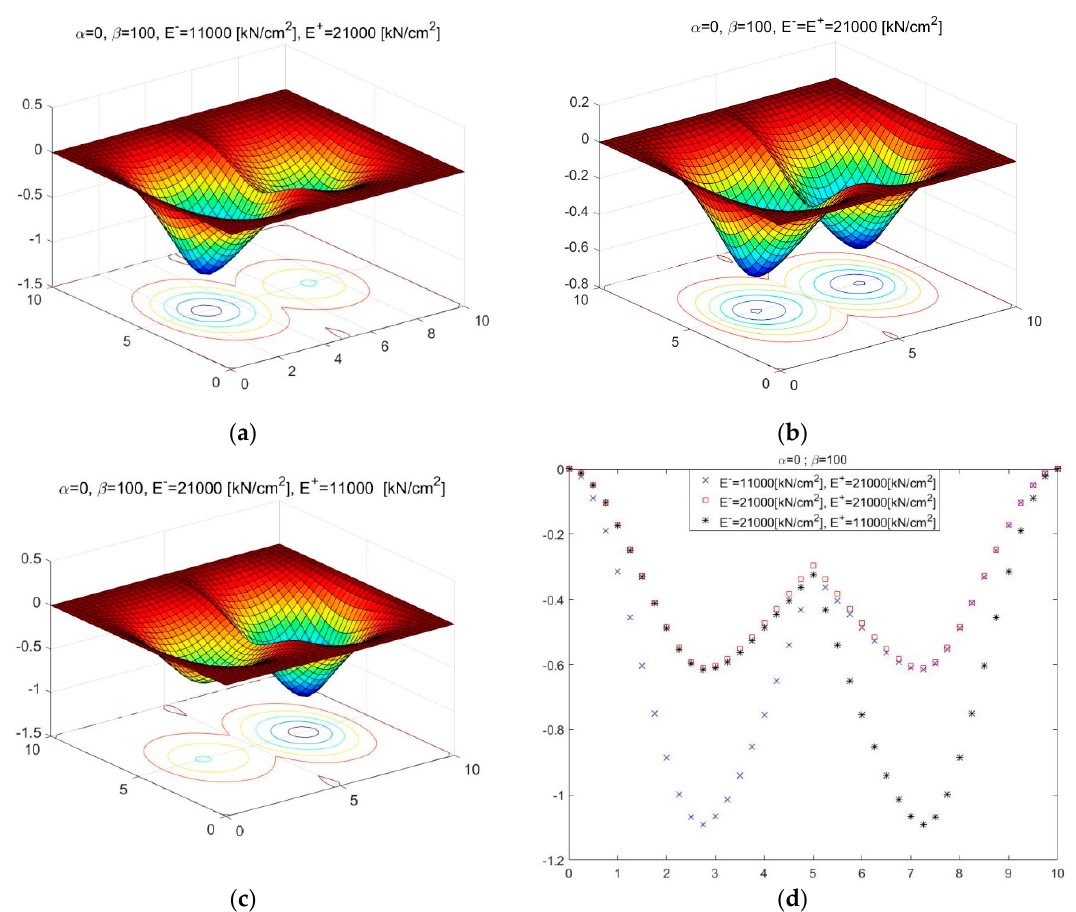
Figure 2. The bendings of the plate system corresponding to cases (i)–(iii) in ( a )–( c ), and the cross sections of the bendings on x 2 = (cid:96) 2 /2 in ( d ) in the case of α = 0, β = 100.